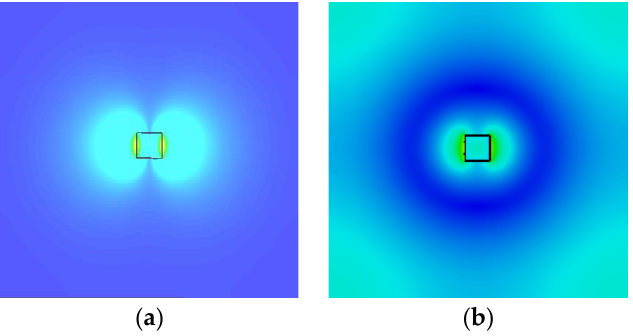
Figure 12. Electric field distributions of ( a ) guided mode and ( b ) leaky mode at 10 GHz in the cross-plane for a = 7.2 mm simulated by CST Eigenmode Solver.